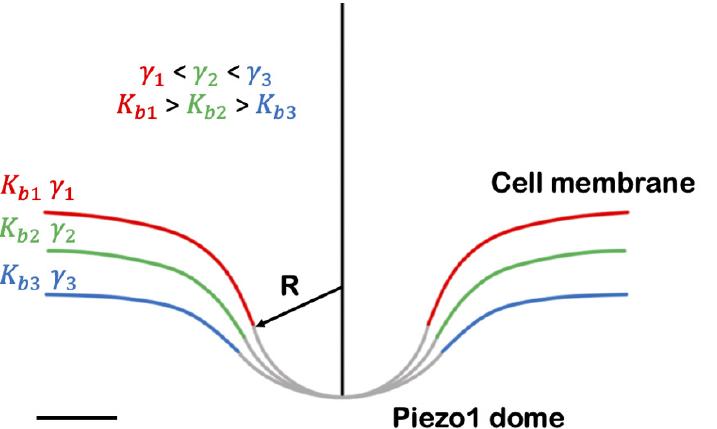
Figure 2. Section view of Piezo dome (gray) and deformation imposed on the cell membrane (red, green, blue). The three physical parameters and their relative relationships involved in the regulation of membrane shape are reported: R (radius of curvature of the dome), K b (membrane bending modulus), and γ (membrane tension). Scale bar: 10 nm.